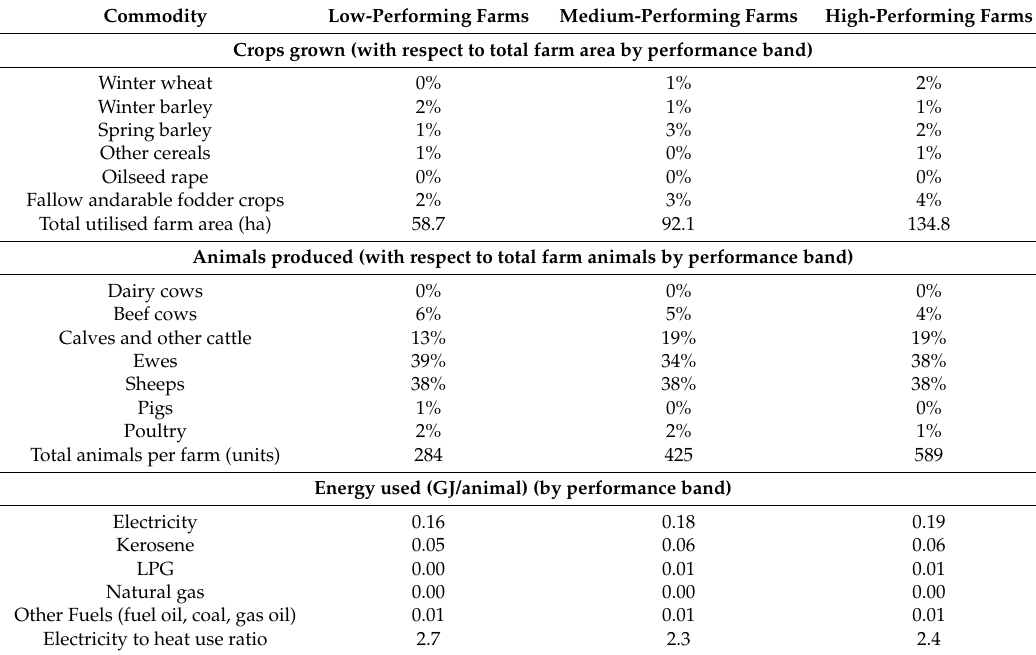
Table 4. Annual Lowland farm input and output characteristics